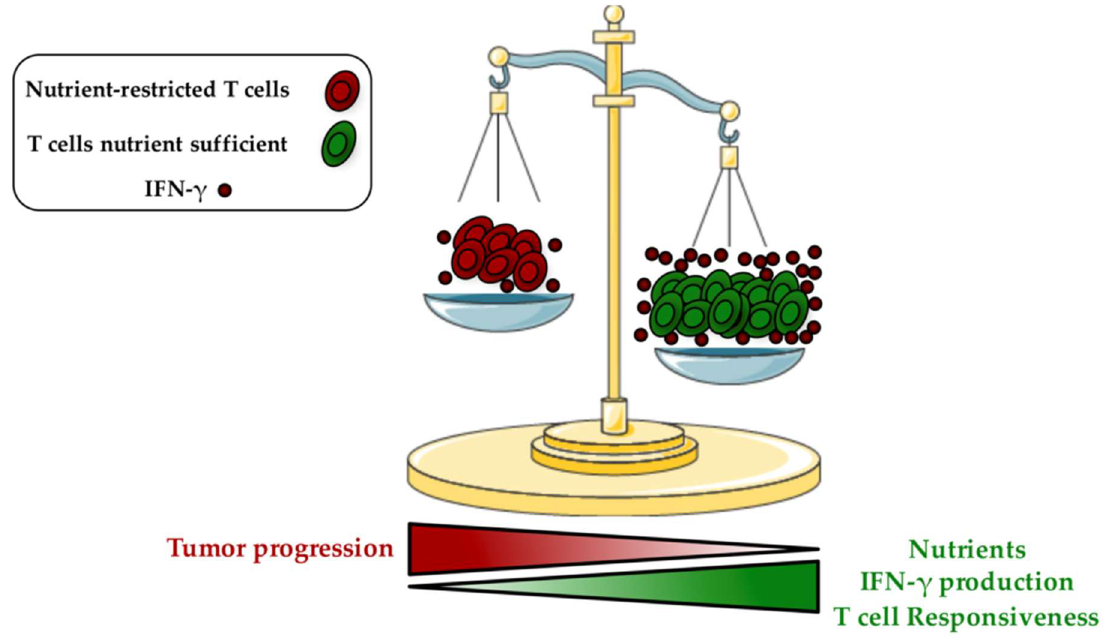
Figure 1. Metabolic competition in the tumor microenvironment is a driver of T cell responsiveness. As mentioned in the review's text, the increased metabolism displayed by tumor cells consumes most nutrients from the surrounding microenvironment, and as a consequence, impacts on the intrinsic metabolism of T cells, with a decreased ability to produce cytokines (especially IFN-γ) and to develop into tumor-specific T effector cells, leading to T cell hypo-responsiveness and increased tumor progression (nutrient-restricted T cells in red). Conversely, in a nutrient-enriched microenvironment, T cell metabolism increases (glycolysis) and leads to an improved IFN-γ production and immune response (T cells nutrient sufficient in green). IFN-γ: Interferon gamma. + CD4 Treg cells hamper inflammation and are (1) often associated with increased